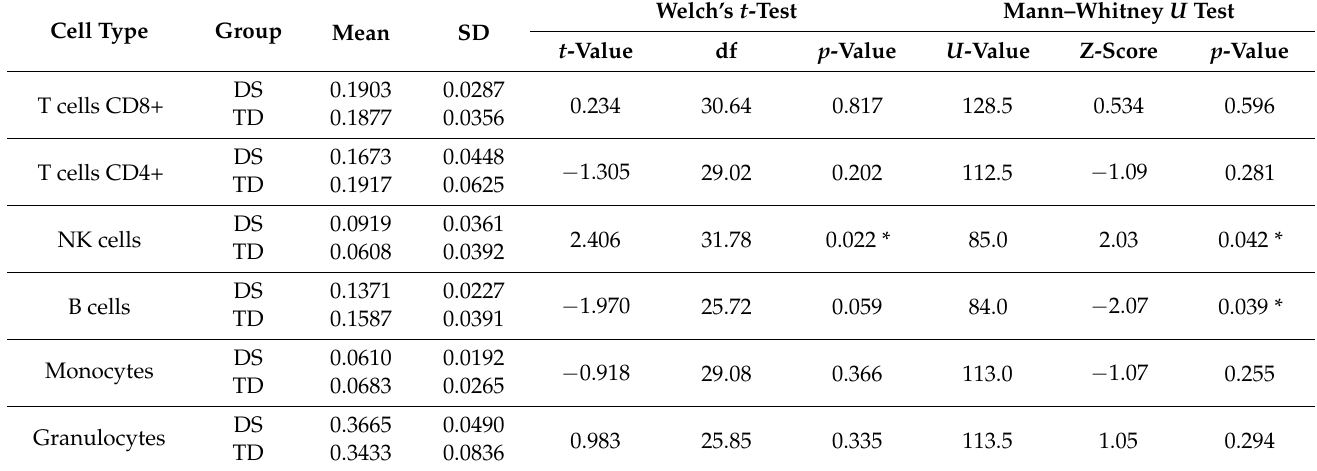
Table 2. The distribution of blood cell types estimated based on DNA methylation data in toddlers with Down syndrome (DS) and typically developing peers (TD) and statistics on the intergroup comparisons of the cell-type compositions; p -values < 0.05 marked by